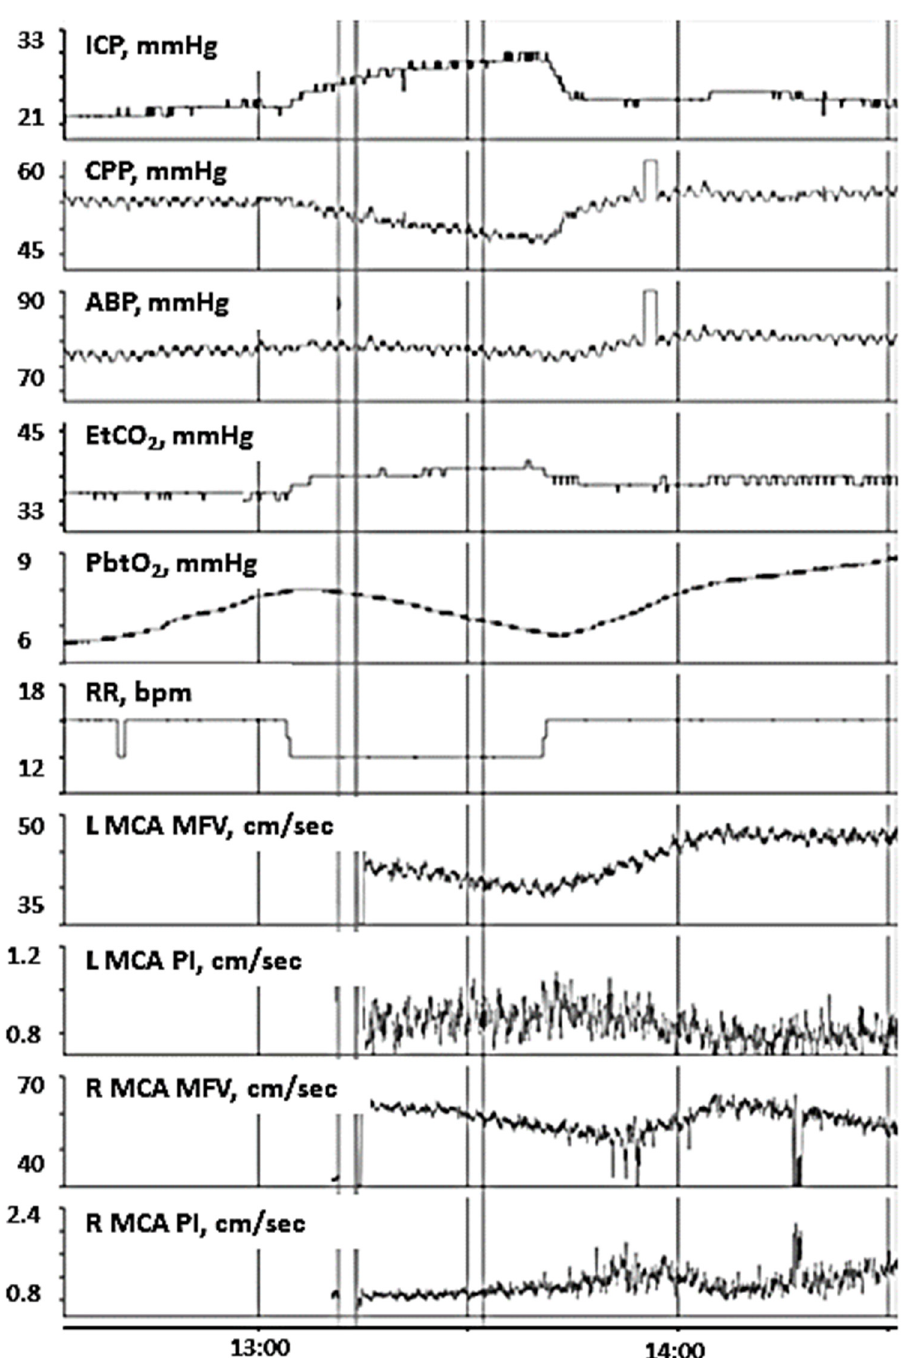
Figure 2. In patient 14, changes in EtO 2 are positively associated with changes in ICP but is negatively associated with changes in PbtO 2 . This is indicative of impaired CO 2 reactivity to PbtO 2 . Continuous transcranial Doppler ultrasound (TCD) is performed at the same time to assess changes in CBF, demonstrating changes in EtO 2 are negatively associated with bilateral MCA MFV and positively associated with PIs. These findings suggest that increased EtO 2 may increase cerebral edema and lead to resultant intracranial hypertension, brain tissue hypoxia, and resistive CBF in the major basal arteries. Abbreviations: ICP, intracranial pressure; CPP, cerebral perfusion pressure; ABP, arterial blood pressure; EtO 2 , end-tidal carbon dioxide; PbtO 2 , partial pressure of brain tissue oxygenation; RR, respiratory rate; bpm, breaths per minute; L, left; R, right; MCA, middle cerebral artery; MFV, mean flow velocities; PI, pulsatility index; cm, centimeters; sec, second; mmHg, millimeters of mercury.